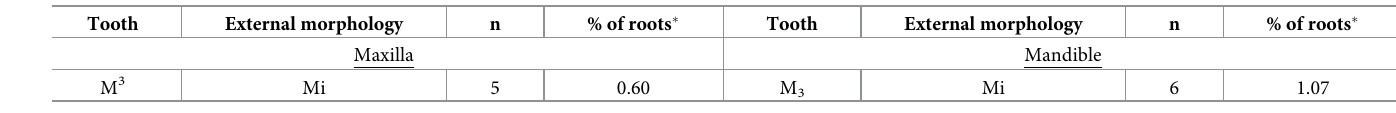
Though some of these morphologies have been discussed in the literature, their descriptions are inconsistent (e.g., hourglass, plate). Table 6 includes definitions and descriptions of the root morphologies shown in Fig 12. Two of the morphologies, wedge (W) and kidney (K), are described here for the first time. External root morphologies appear in different frequencies in each tooth, and some mor- phologies do not appear in some teeth at all (Table 7). The number of morphologies increase posteriorly along the tooth row, and M s have the most morphologies. Part of this is due to the 1 number of bifid (Bi) variants (e.g., EBi, PBi, etc.), as well as the presence of pegged and fused roots (Tables 8 and 9, respectively). Pegged (Mi) roots while globular in cross section, are therefore considered their own dis- tinct morphology as they are a form of microdontia [83]. They are relatively rare in this sample and only appear in M 3 and M (Table 8). 3 Fused roots are almost always found in the molars and are more common in the maxillary molars (Table 9). In almost all cases fusion includes the mesial (M) root, and it is not uncom- mon for fused roots to have some degree of bifurcation (Bi). Table 8. Type and number of teeth with pegged roots. Tooth External morphology n